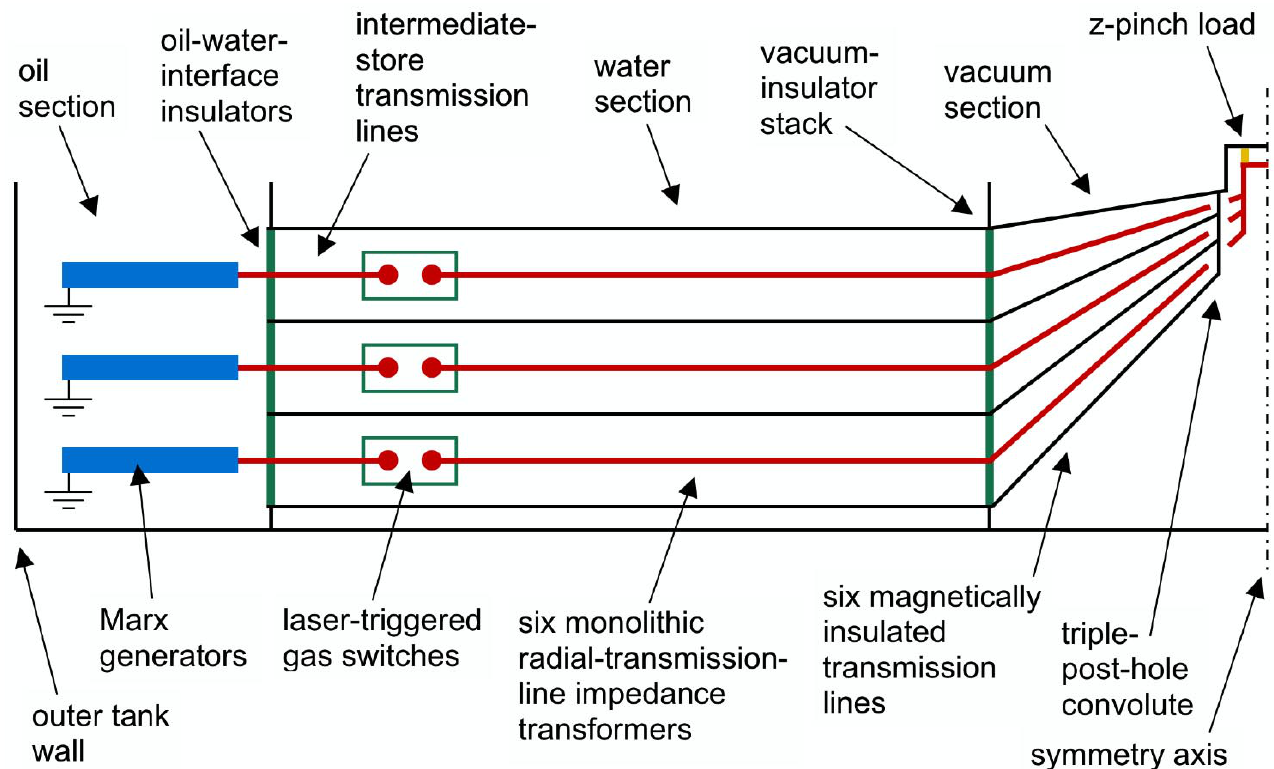
FIG. 1. (Color) Conceptual design of a Marx-based petawatt-class z -pinch driver. The anode electrodes are black; the cathodes are red. This particular design includes 3 levels of Marx generators, 6 intermediate-store transmission lines (3 triplates), 6 monolithic radial- transmission-line impedance transformers (3 triplates), a 6-level vacuum-insulator stack, 6 magnetically insulated transmission lines, a triple-post-hole vacuum convolute, and a z -pinch load. The anode-cathode gaps of the water-insulated transformers are shown here as being independent of radius; however, the actual gaps would likely vary to achieve an exponential impedance profile. (The drawing is not to